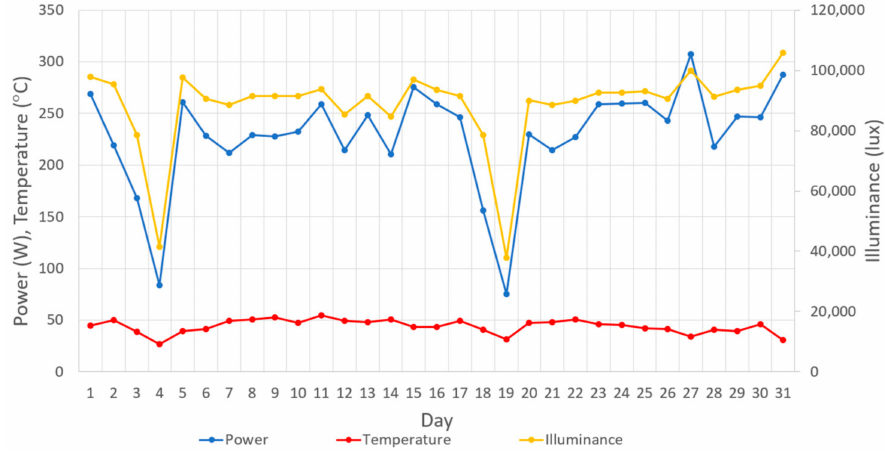
Figure 9. Power graph and illuminance in August 2020.